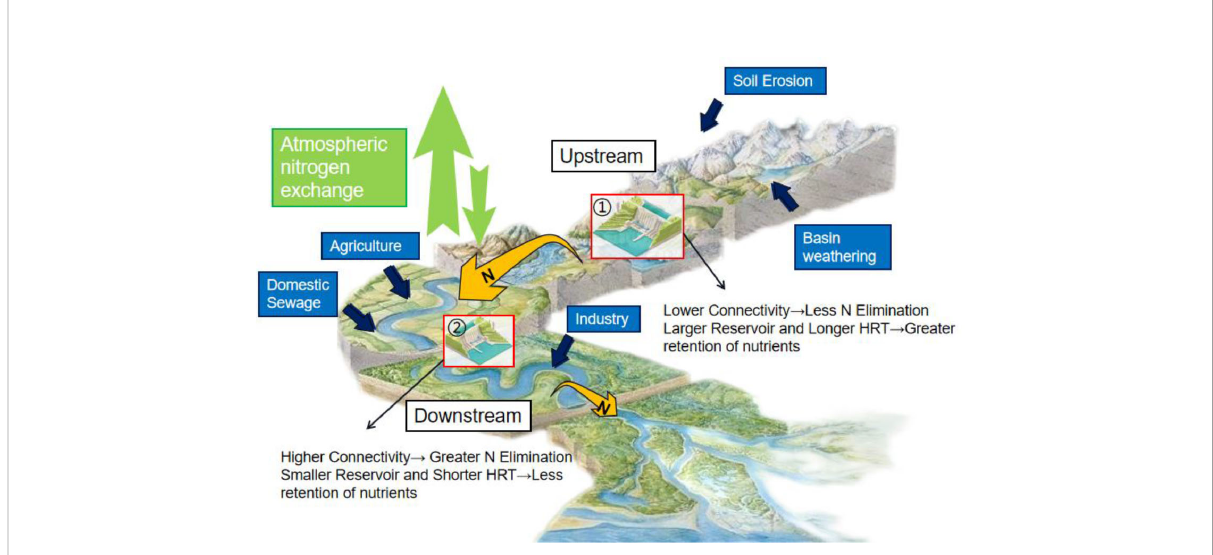
FIGURE 5 The in fl uence of river hydrological factors on the migration and transformation of nutrients. HRT, hydraulic retention